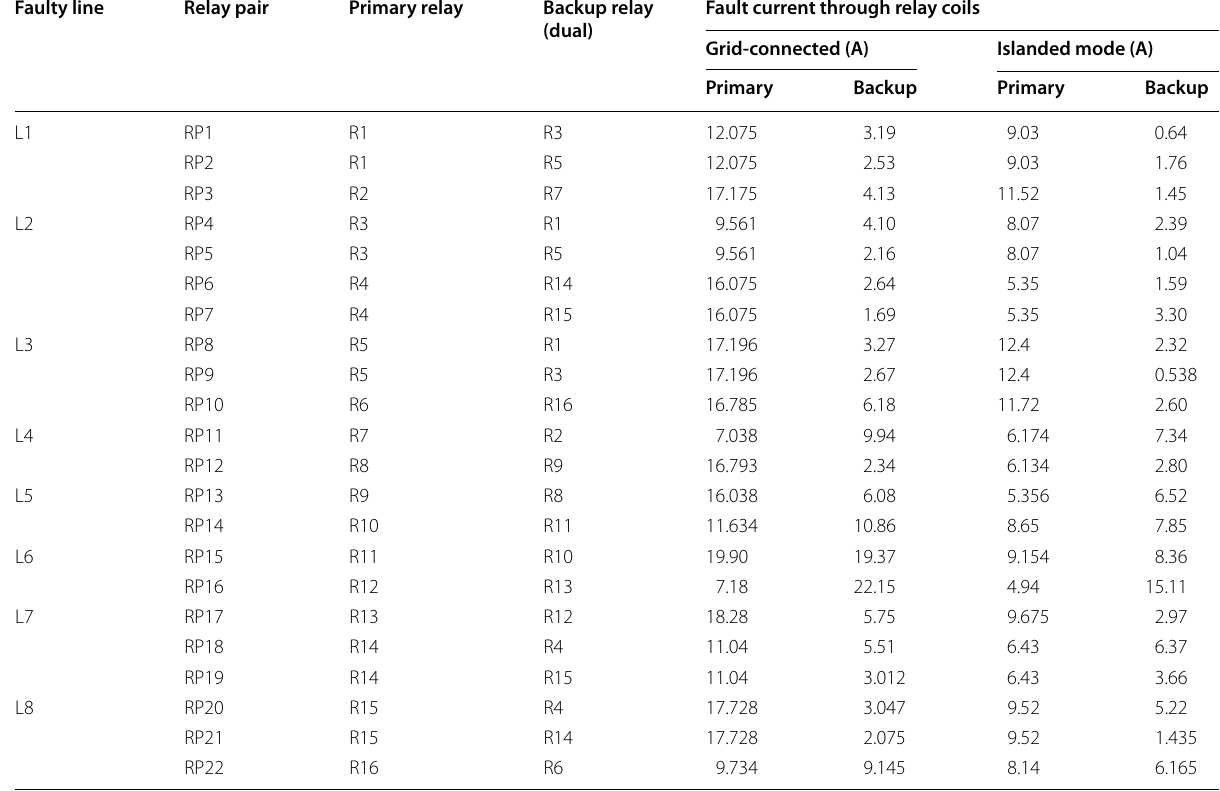
Table 3 Current through relay coils in grid-connected and islanded operating modes for 7-bus microgrid system Faulty